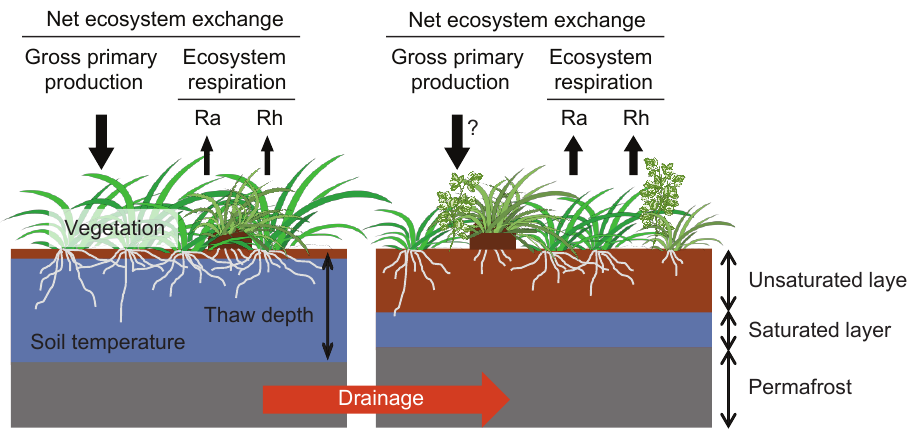
Figure 1. A schematic showing how a decade-long drainage installation affects a floodplain ecosystem and CO 2 fluxes. Drainage of a floodplain ecosystem alters T soil through changing heat capacity and thermal conductivity, with increased T soil in shallow layers, decreased T soil in deeper layers, and shallower TDs, as well as decreasing the abundance of wetland grasses while increasing the abundance of shrubs. These modifications will subsequently affect CO 2 fluxes by changing the rates of GPP and possibly increasing R eco , which consists of R a and R h .